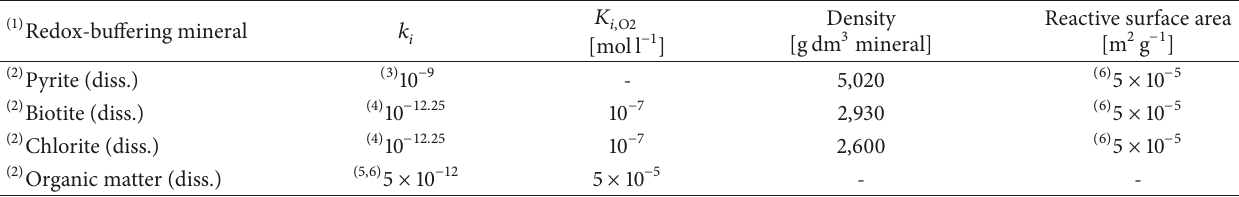
Figure 2: Initial distribution of the volumetric contents of redox-buffering minerals. (a), (b), (c), and (d) are pyrite, organic matter, biotite, and chlorite contents, respectively. Vertical exaggeration 100: 1. Table 3: Kinetic parameters and solid properties for the redox-buffering minerals used in base case